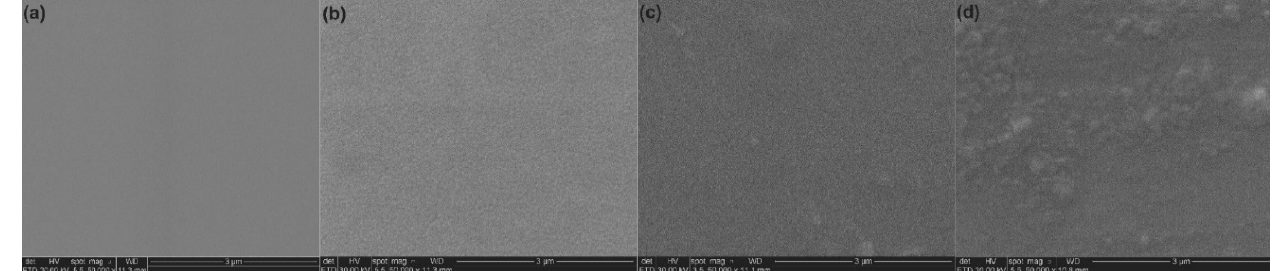
Figure 5. SEM images obtained on Si ( a ), 10 MgHApCh-0 ( b ), 10 MgHApCh-3 ( c ), and 10 MgHApCh-6 ( d ) thin films. ( d ) thin films.